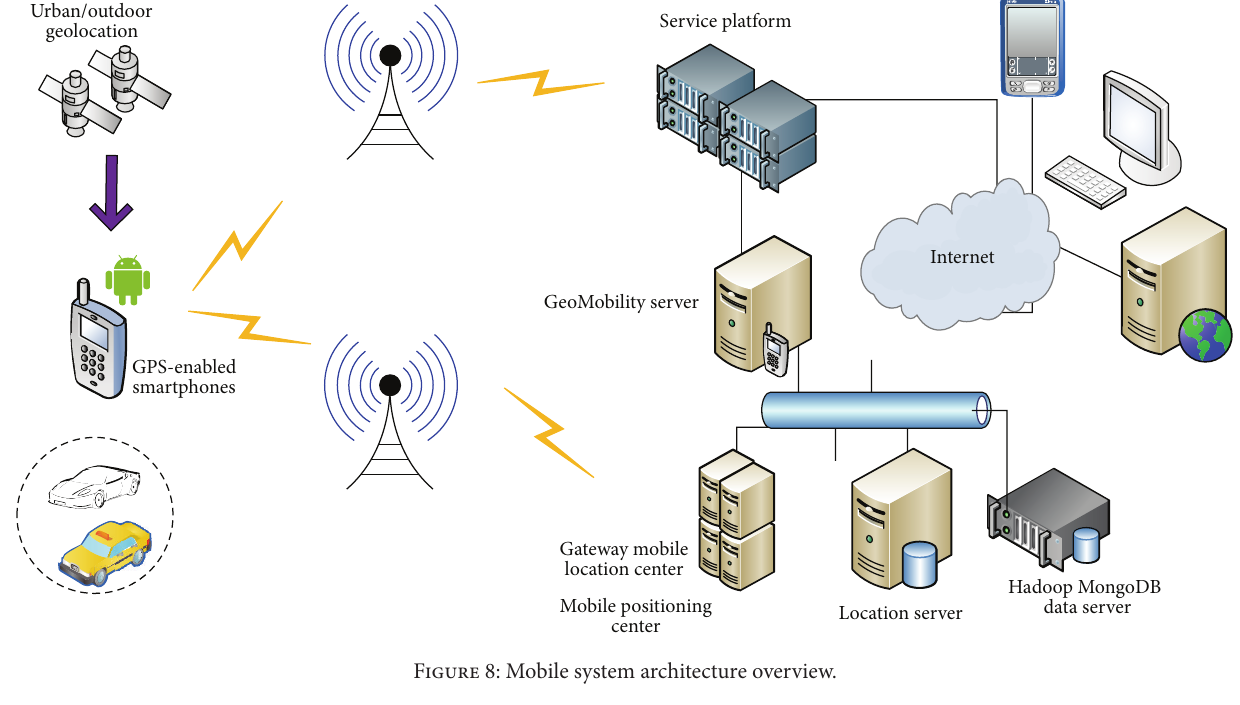
Figure 8: Mobile system architecture overview.